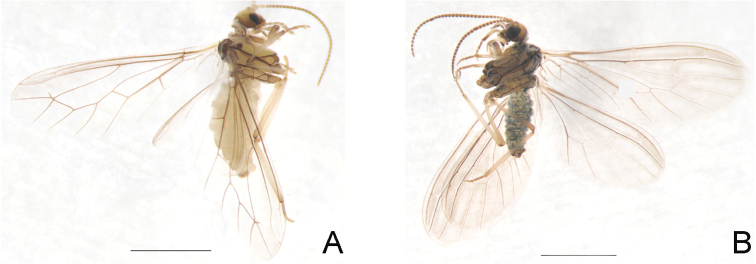
Habitus photographs of species of Coniopterygidae newly recorded from Beijing. AConwentziasinica Yang, 1974 BSemidalisbicornis Liu & Yang, 1993. Scale bar: 1 mm.